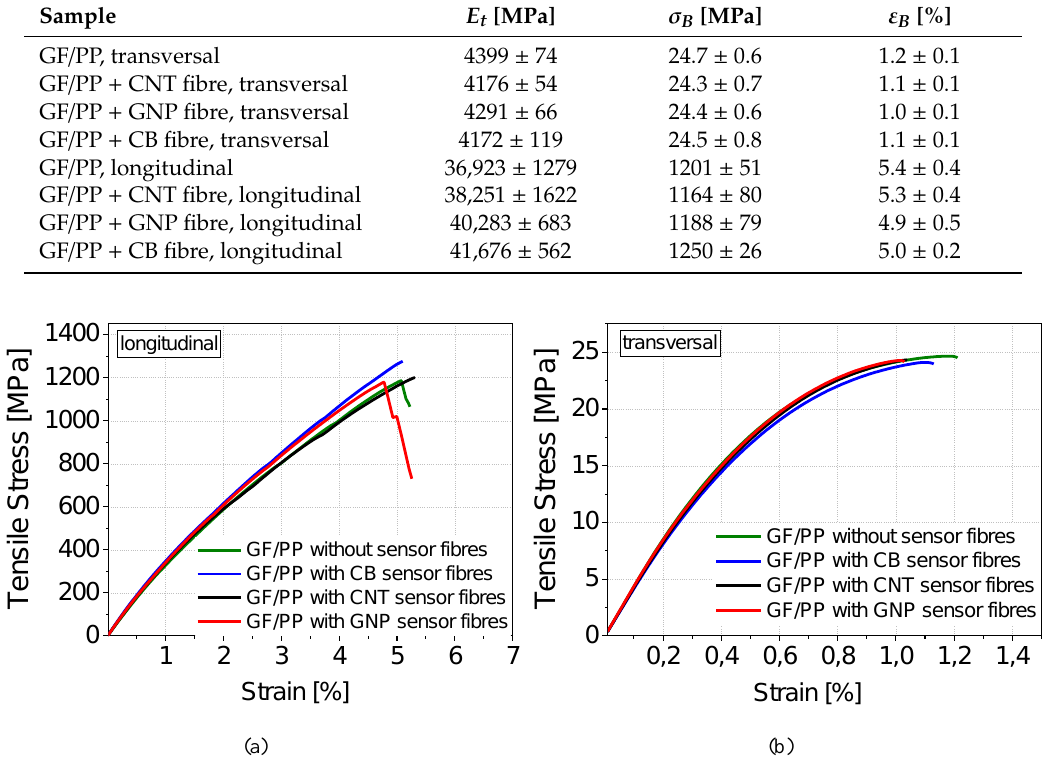
Figure 9. Representative tensile curves for tensile behaviour, longitudinal ( a ) and transversal ( b ) of a unidirectional GF/PP composite with one centrally embedded sensor fibre (nanostructured with 5 wt.% CNT, 5 wt.% GNP and 10 wt.% CB, respectively); representative tensile curves are shown.